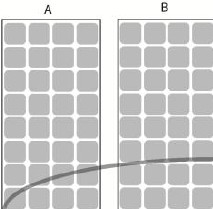
Figure 8. Shadow from a linear object on photovoltaic module